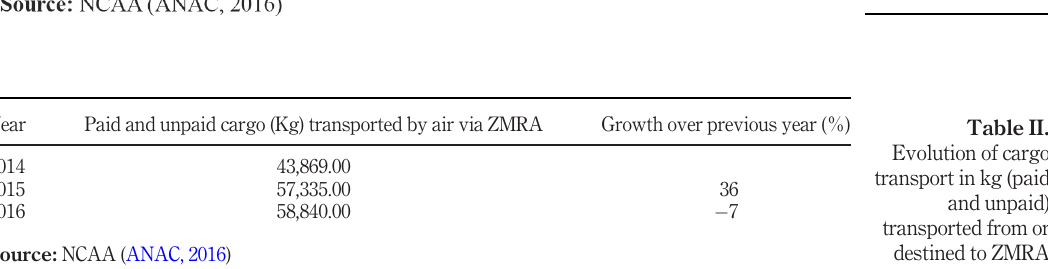
Figure 6. Evolution of the number of passengers (paying and non-paying) of regular aviation who embarked or disembarked in ZMRA